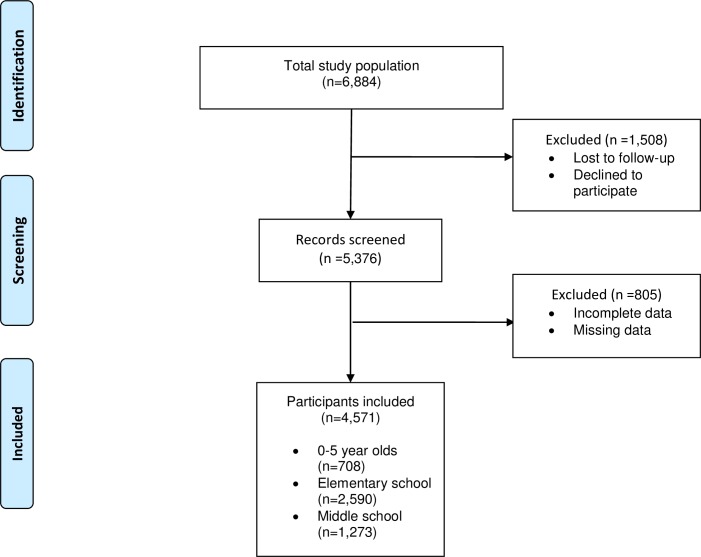
Flow chart of the study participants.